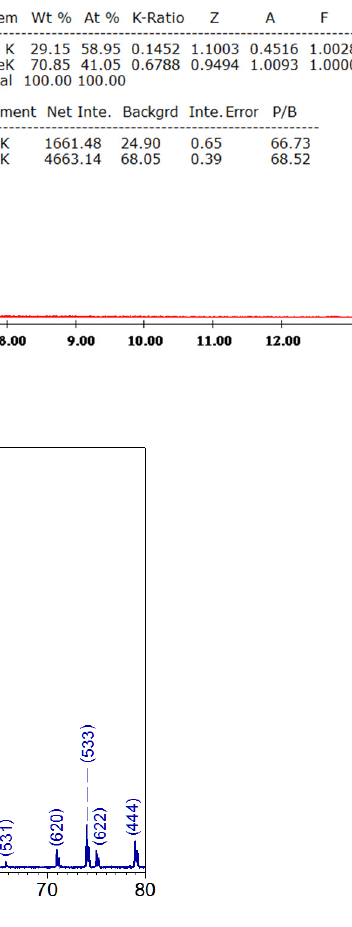
Figure 3. The XRD record of the microcrystal powder.